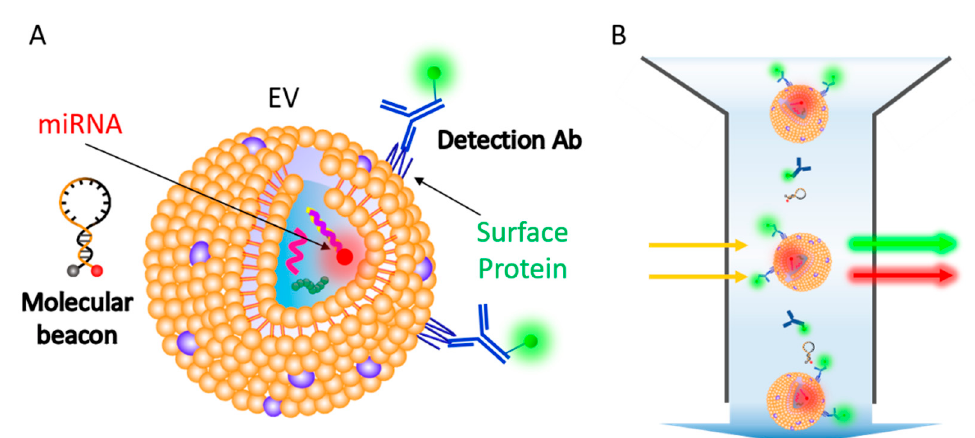
Figure 1. Schematic representation for single step in situ detection of extracellular vesicles (EV) surface proteins and miRNAs using a flow cytometer. ( A ) EV surface proteins and miRNA markers can be simultaneously detected using fluorescent dye-conjugated antibodies and molecular beacons. ( B ) A single step flow cytometric analysis of EV proteins and miRNAs.